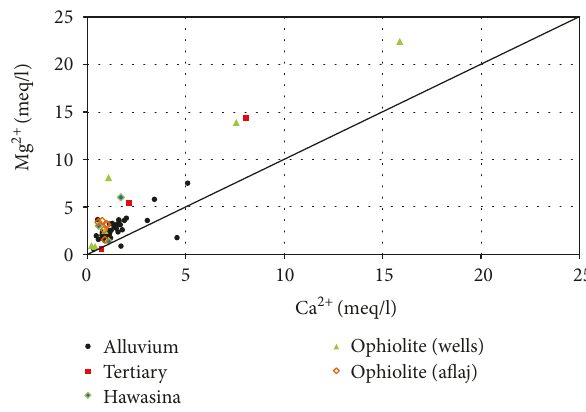
Figure 3: Mg vs. Ca ratio. The solid line indicates 1: 1